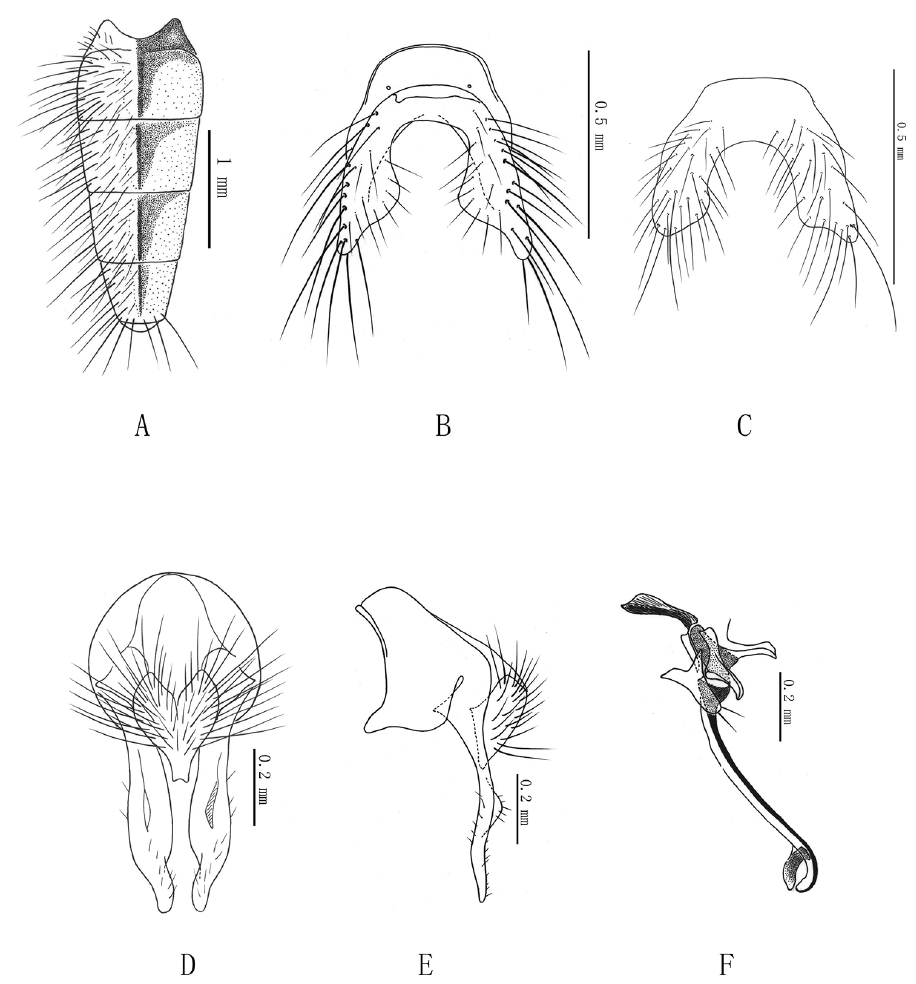
Figure 4. Delia tuberisurstyla sp. n. A male, abdomen in dorsal view; B male, 5 th sternite in ventral view, in holotype; C male, 5 th sternite in ventral view, in paratype D male, terminalia in posterior view E male, terminalia in profile F male, aedeagus in